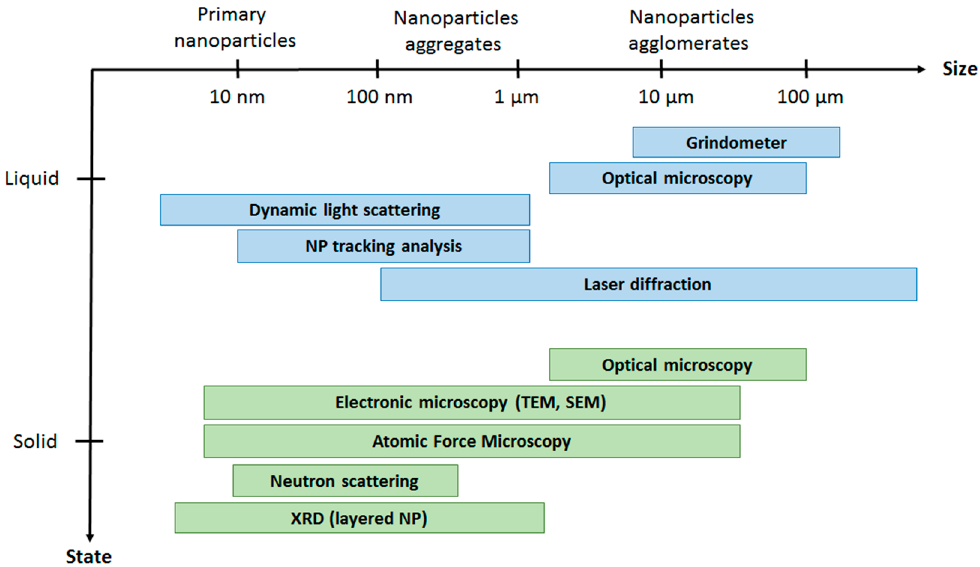
Figure 3. Conventional characterization techniques to evaluate nanoparticles’ dispersion in different media.